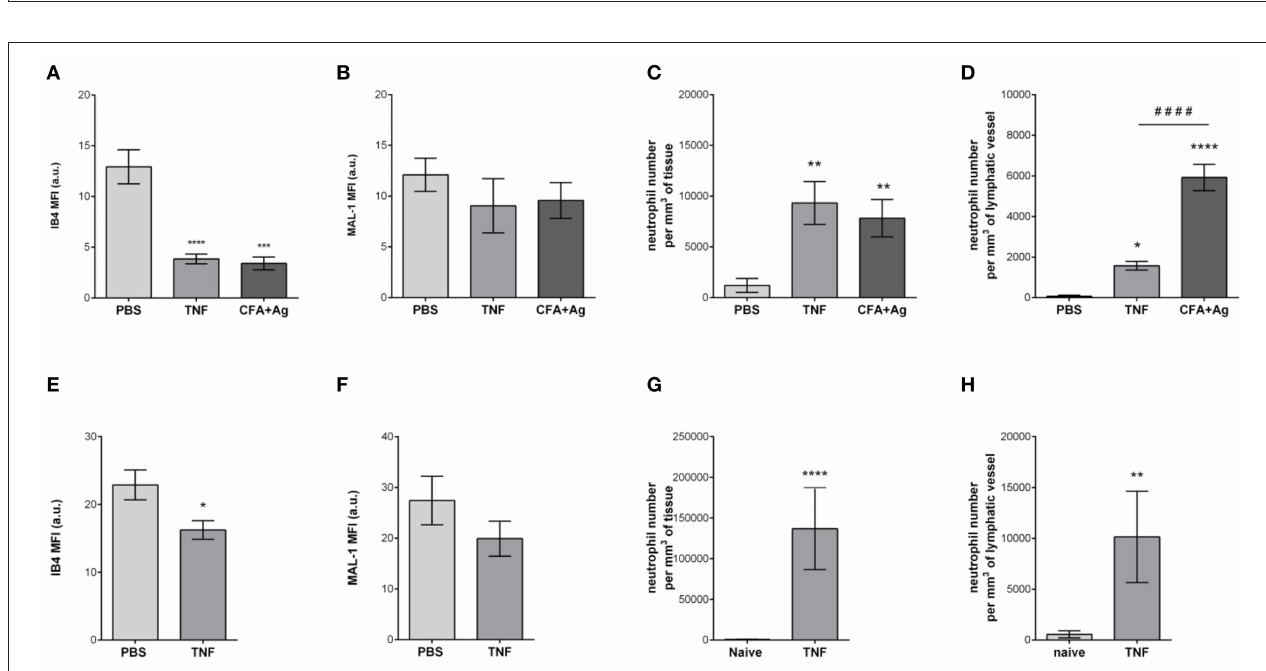
FIGURE 5 | Selective cleavage of initial lymphatic vessels glycocalyx during acute inflammation. The cremaster muscles of mice were stimulated following intrascrotal (i.s.) injection of TNF (300 ng) or CFA + Ag (200 µ g). Control mice were injected with PBS. For 2h before the end of the inflammation period, mice were further injected i.s. with IB4 or MAL-1 and anti-LYVE-1 Abs to reveal glycan chains and lymphatic vessels, respectively. At the end of the inflammation period, the cremaster muscles were harvested, fixed, and immunostained for neutrophils (anti-MRP14 mAb) prior to the visualization and quantification of the inflammatory response by confocal microscopy. For ear stimulation, the dorsal skin of mouse ears were injected with TNF (300 ng); and 16h later, ears were harvested, fixed and stained whole-mount with fluorescently-labeled IB4 or MAL-1; anti-LYVE-1 and anti-MRP14 mAbs to reveal glycan chains, lymphatic vessels and neutrophils, respectively, prior to the visualization and quantification of the inflammatory response by confocal microscopy. Control mice were injected with PBS. The mean fluorescence intensity (MFI) for IB4 or MAL-1 binding to the lymphatic glycocalyx was quantified by creating an isosurface on lymphatic vessel channel (LYVE-1), excluding the signal from MRP14 channel using IMARIS software. (A) Mean fluorescence intensity (MFI) for IB4 staining on cremaster lymphatic vessels. (B) Mean fluorescence intensity (MFI) of MAL-1 staining on cremaster lymphatic vessels. (C) Number of neutrophils into the cremaster interstitium. (D) Number of neutrophils into the cremaster initial lymphatic vessels. (E) Mean fluorescence intensity (MFI) for IB4 staining on ear skin lymphatic vessels. (F) Mean fluorescence intensity (MFI) of MAL-1 staining on ear skin lymphatic vessels. (G) Number of neutrophils in the ear skin interstitium. (H) Number of neutrophils within the ear skin initial lymphatic vessels. Results are from n = 4–6 vessels per tissue with at least 5 animals per group. Statistically significant differences between stimulated and unstimulated treatment groups are indicated by: * P < 0.05, ** P < 0.01, *** P < 0.001, **** P < 0.0001. Statistically significant differences between TNF-stimulated and CFA + Ag-stimulated tissues are indicated by: #### P <